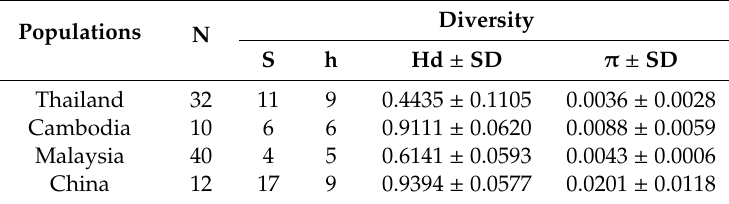
Table 3. Summary of the genetic diversity of the 4 populations of A. ceylanicum based on the nucleotide sequences of the partial mitochondrial cox1 gene.